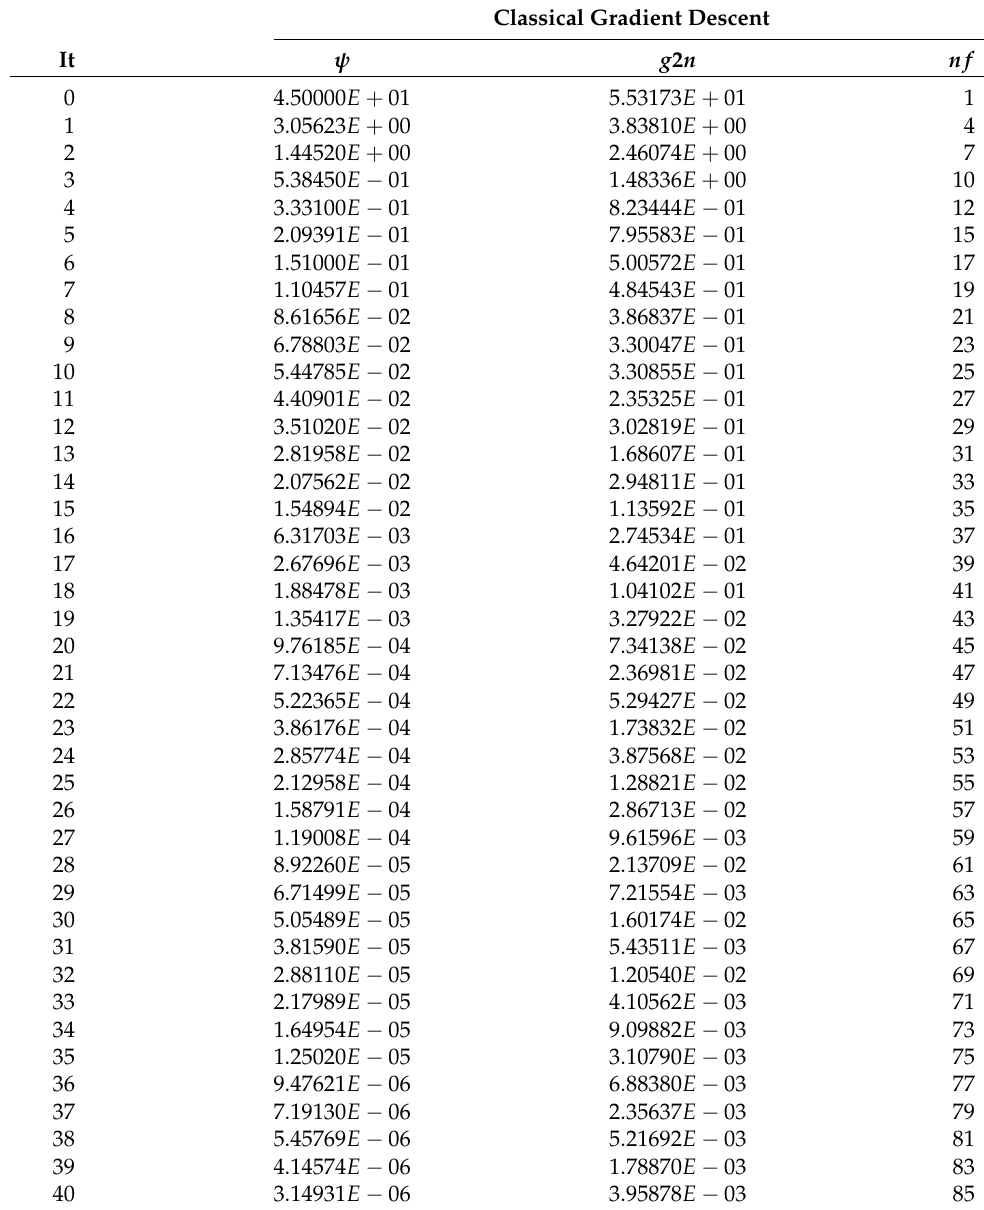
Table 3. Numerical results of Example 3 using Classical Gradient Descent